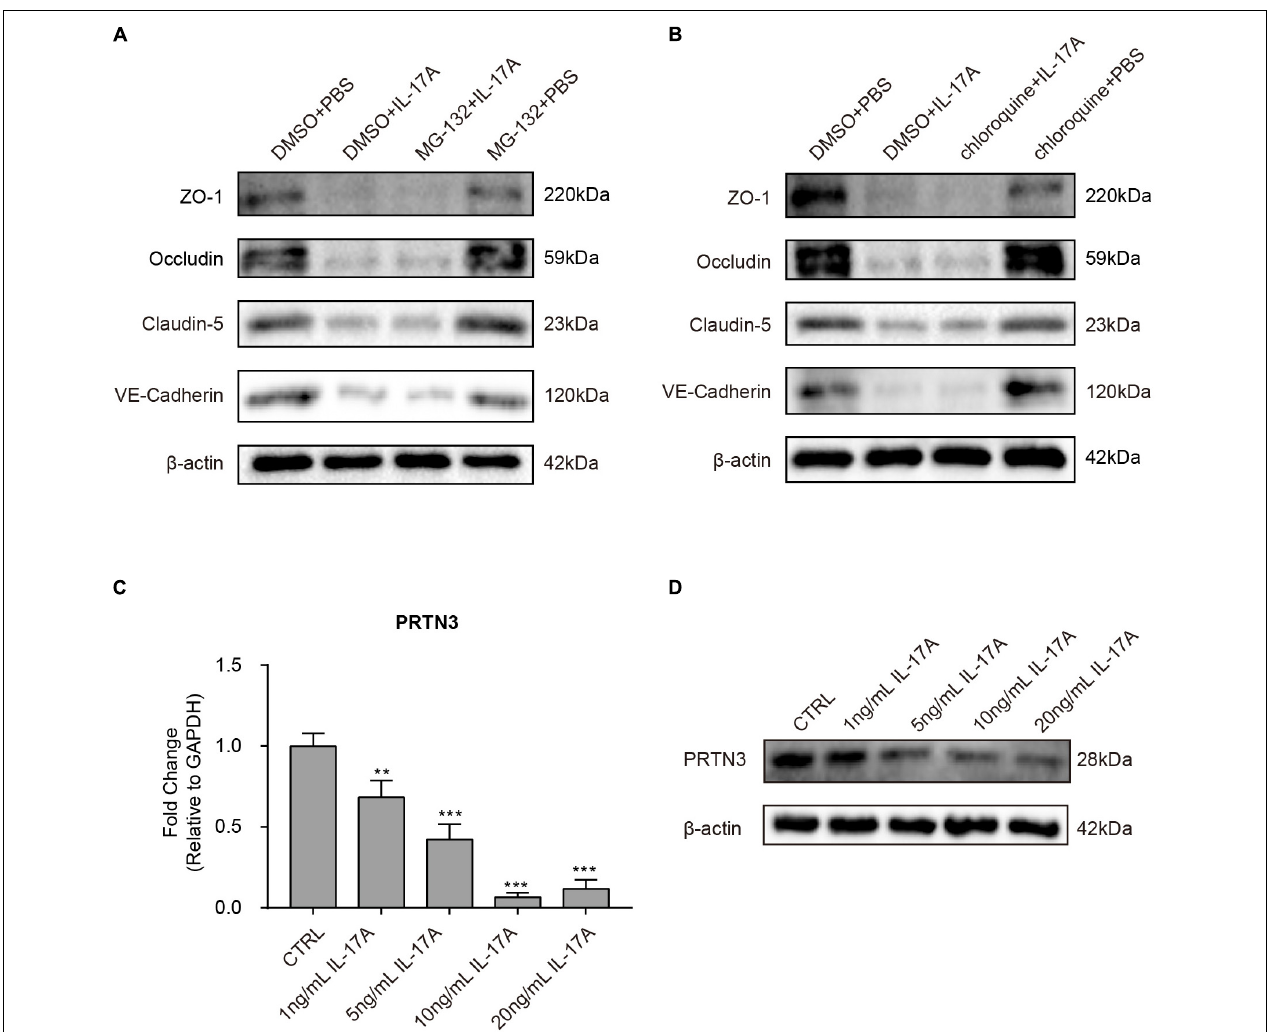
FIGURE 4 | Interleukin-17A treatment decreases PRTN3 expression hBMECs. Western blot analysis of ZO-1, Occludin, Claudin-5, and VE-Cadherin extracted from IL-17A untreated hBMECs and IL-17A treated hBMECs with or without the presence of Proteasome inhibitor MG-132 (A) or autophagy inhibitor chloroquine (B) . β -Actin was used as the loading control. (C) The qPCR analysis of PRTN3 transcription in hBMECs treated by multiple dosages of IL-17A (0, 1, 5, 10, and 20 ng/mL). GAPDH was used as the internal reference. Data were presented as mean ± SD from three independent experiments. ** p < 0.01 and *** p < 0.001 by one-way ANOVA analysis. (D) Western blot analysis of PRTN3 in hBMECs in response to multiple dosages of IL-17A. β -Actin was used as the loading